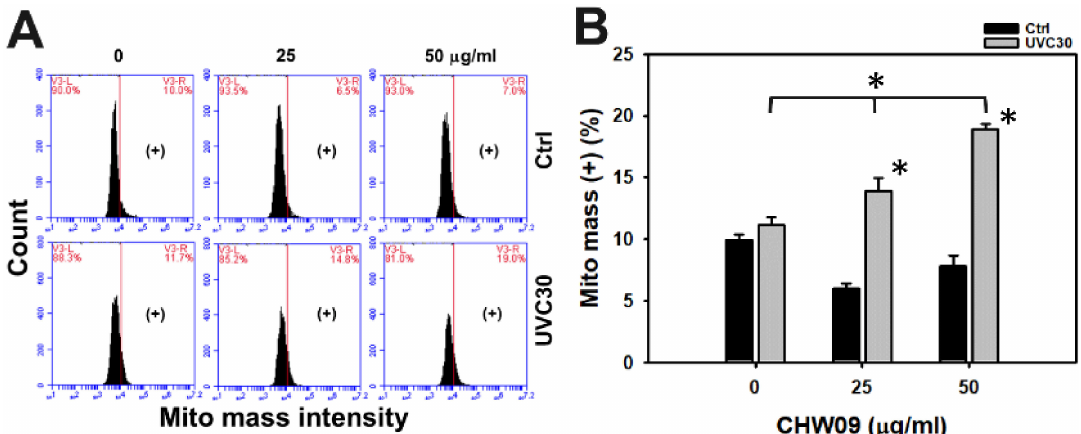
Figure 7. Changes of Mito mass of UVC and / or CHW09 treatments in oral cancer Ca9-22 cells. Cells were pretreated with UVC irradiation (0 and 30 J / m 2 ) and / or post-treated with CHW09 (control, 25, 50 µ g / mL) for 24 h. ( A ) Representative pattern of mito mass analysis for UVC and / or CHW09 treatment. ( + ) in the right side of each panel indicates the mito mass ( + ) (%). ( B ) Statistics in Figure 7A. Data, mean ± SD ( n = 3 independent experiments). For multiple comparison, significance of the di ff erence was examined by one-way ANOVA and the Tukey HSD Post Hoc Test. *, p < 0.0001. * without line indicates the significance between control and UVC30. * with line indicates the significance between UVC30 / CHW09 and others.